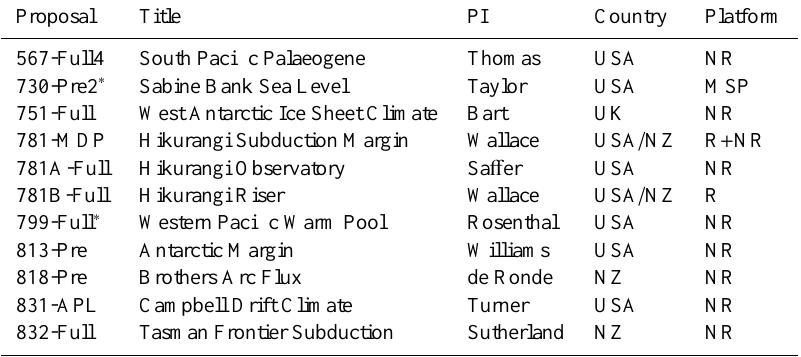
Table 1. List of proposals in the southwest Pacific region. Note: NR = riserless, R = riser and MSP = mission-specific platform drilling